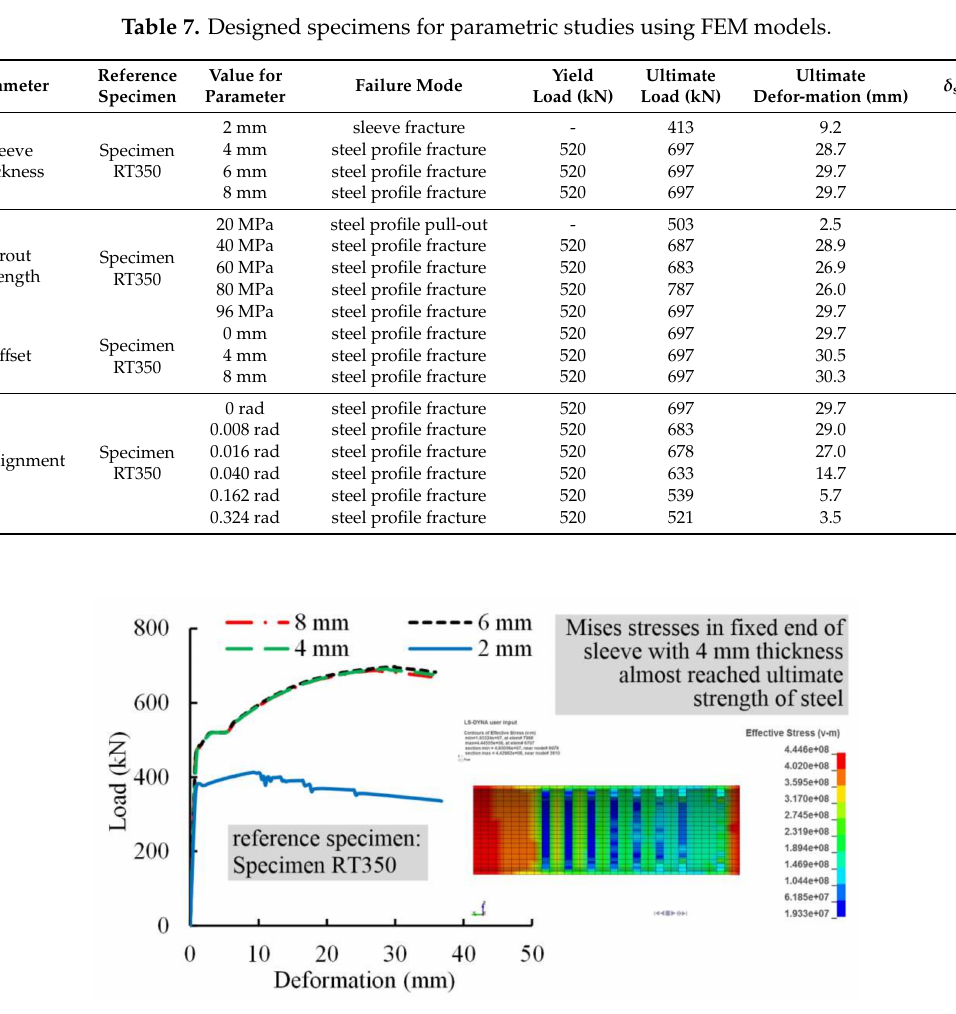
Figure 18. Load-deformation curves for specimens with di ff erent sleeve thicknesses using FEM